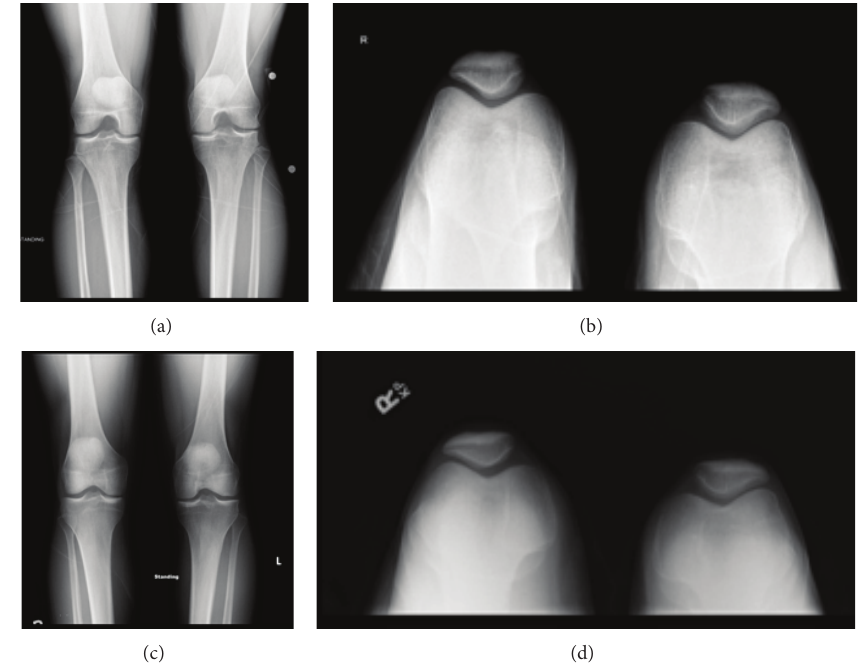
Figure 1: AP and sunrise knee radiographic images of a 29-year-old male patient at (a-b) 8 months and (c-d) 30 months after an acute ACL injury. The images show progression of osteoarthritic changes in a young male with an ACL-deficient